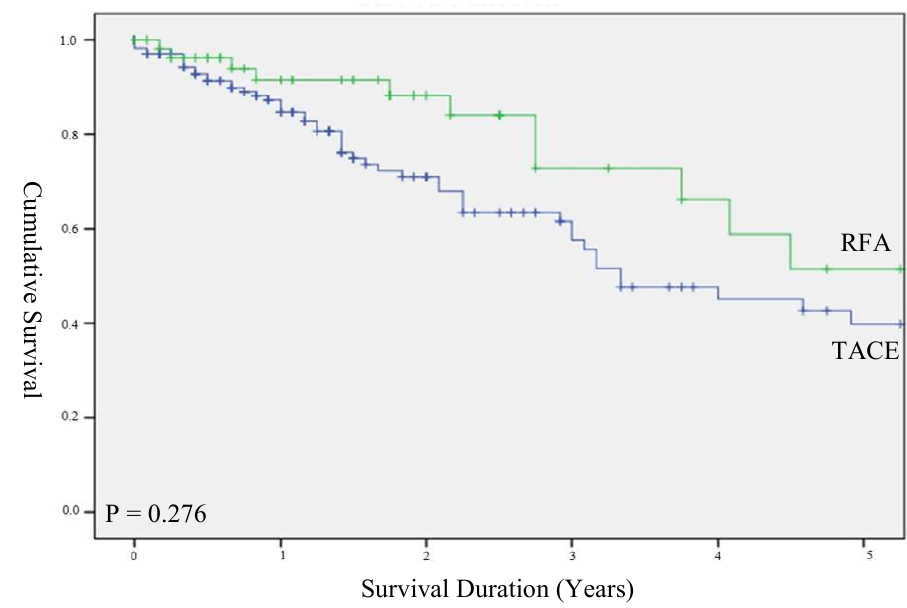
Figure 1. Overall survival in unstratified cohort. Fig. 1 Overall survival in unstratified cohort